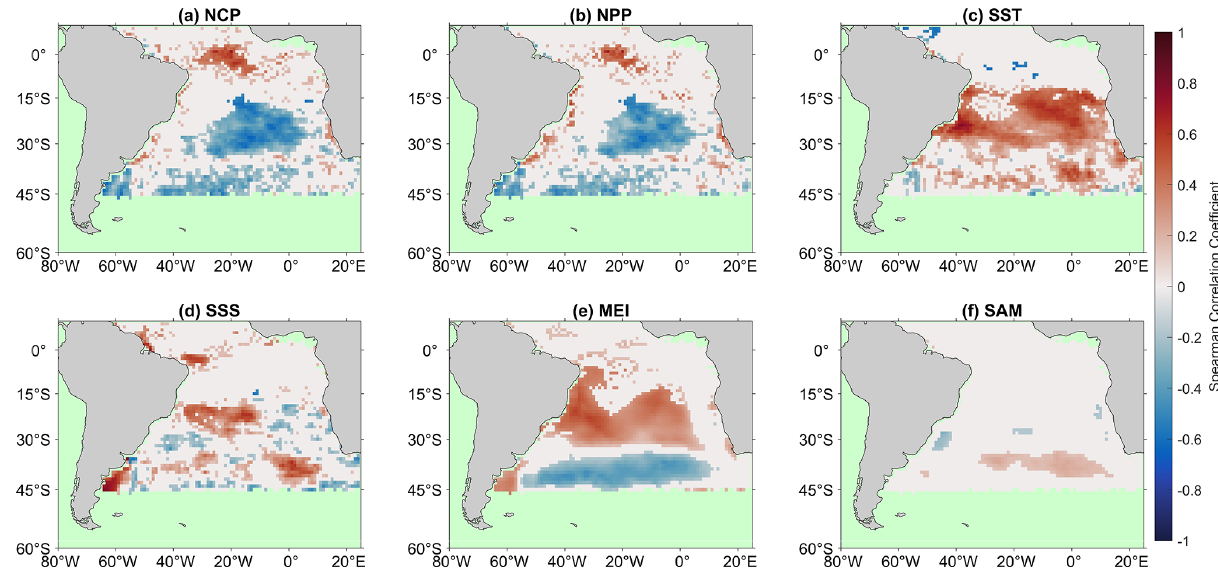
Figure 4. Significant Spearman correlations between the air–sea CO 2 flux inter-annual component of the X-11 analysis and (a) net commu- nity production (NCP), (b) net primary production (NPP), (c) sea surface temperature (SST), (d) sea surface salinity (SSS), (e) multivariate ENSO index (MEI), and (f) Southern Annular Mode (SAM) inter-annual components. White regions indicate no significant correlations, and green regions indicate no analysis was performed due to missing satellite data.